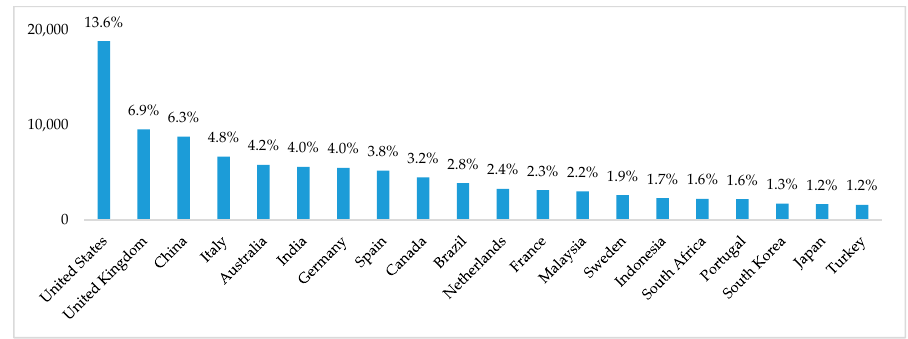
Figure 4. Articles published on sustainability between 2016 and 2020.